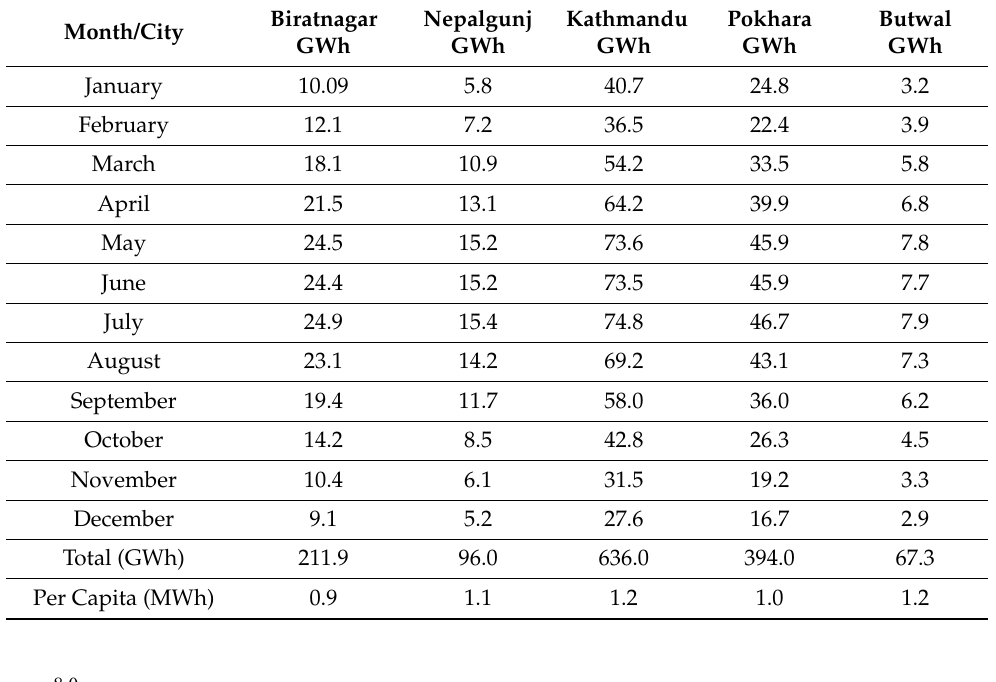
Table 5. Technical generation potential of rooftop photovoltaics in Nepal’s urban centers.